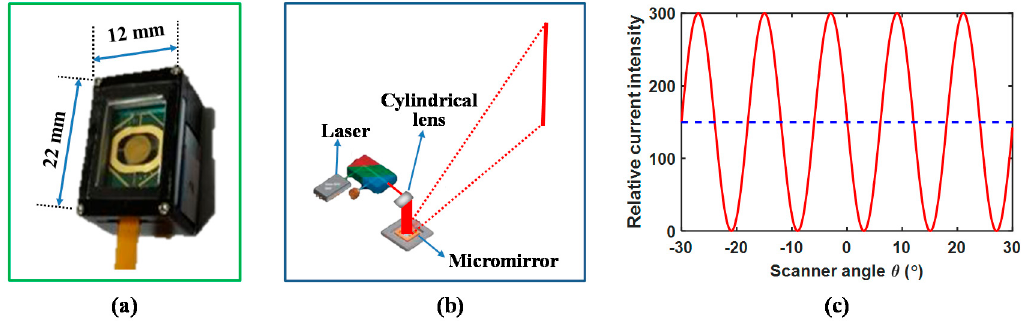
Figure 5. The galvanometer scanner. ( a ) MEMS device; ( b ) Principle of laser scanner; ( c ) The relationship between current intensity and scanning angle.